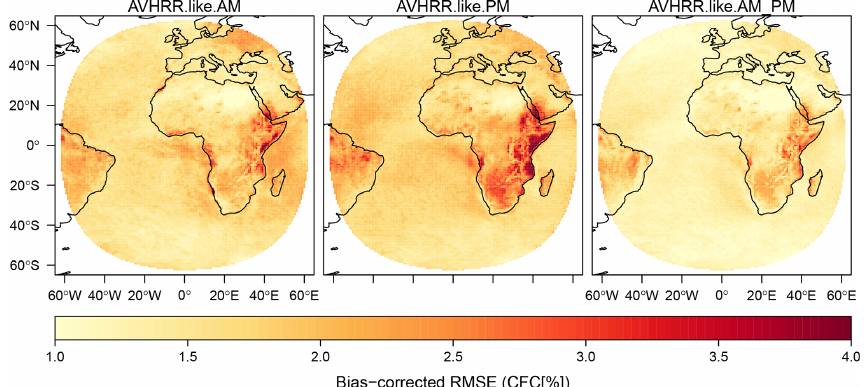
Figure 14. Bias-corrected root mean square error caused by orbital drift and discrete sampling of the CFC diurnal cycle presented for AVHRR-like CDRs derived from morning (AM), afternoon (PM), and combined (AM_PM) satellites.